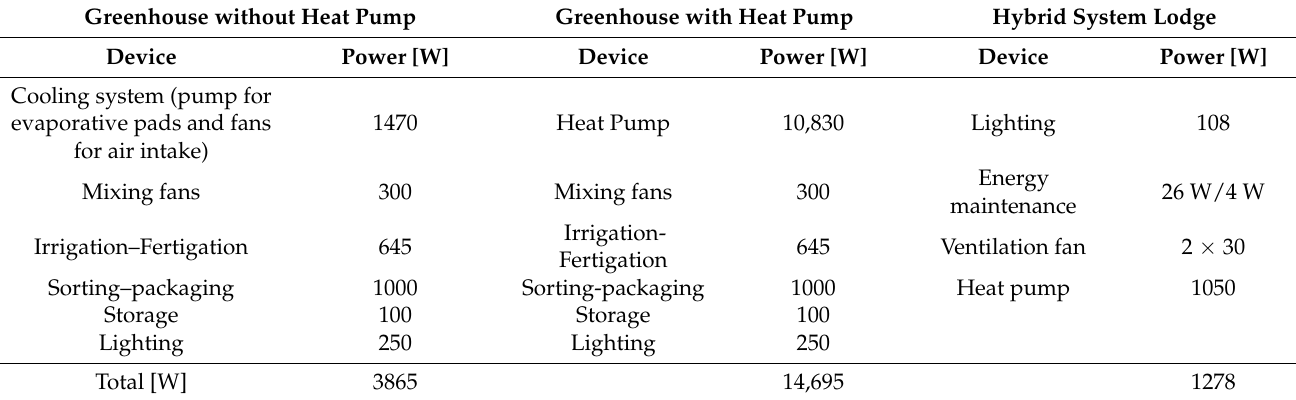
Table 1. Installed